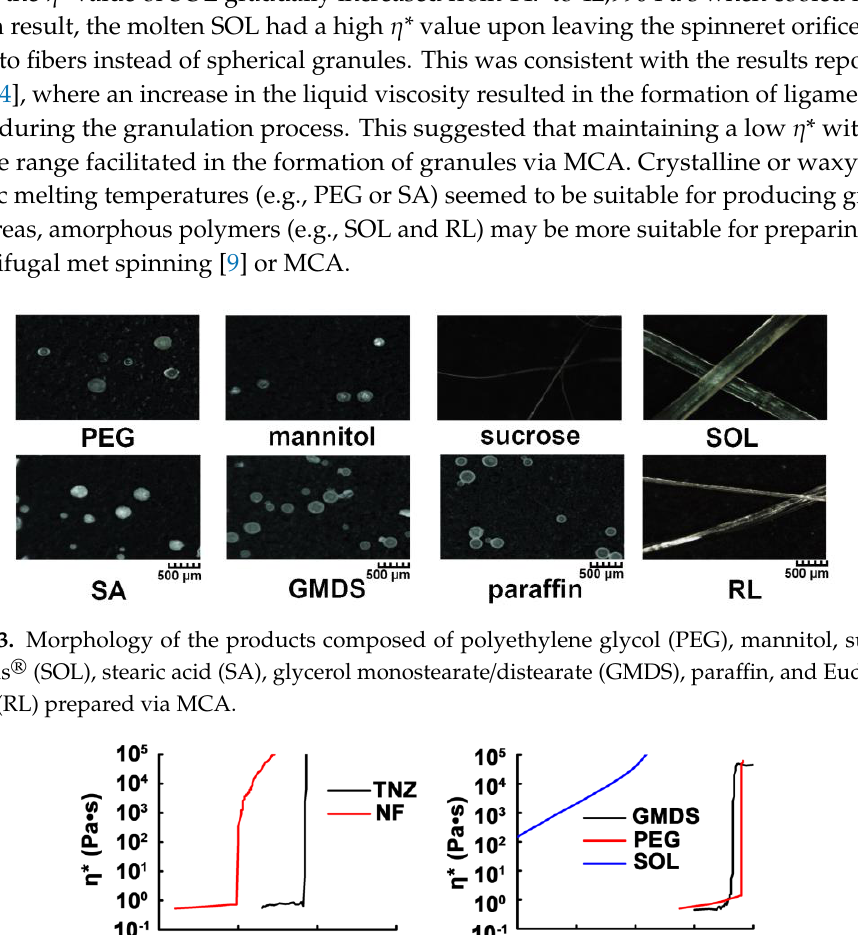
Figure 4. Melt complex viscosity ( η *) curves of ( a ) nifedipine (NF) and tinidazole (TNZ); and ( b ) polyethylene glycol (PEG), Soluplus ® (SOL), and glycerol monostearate/distearate